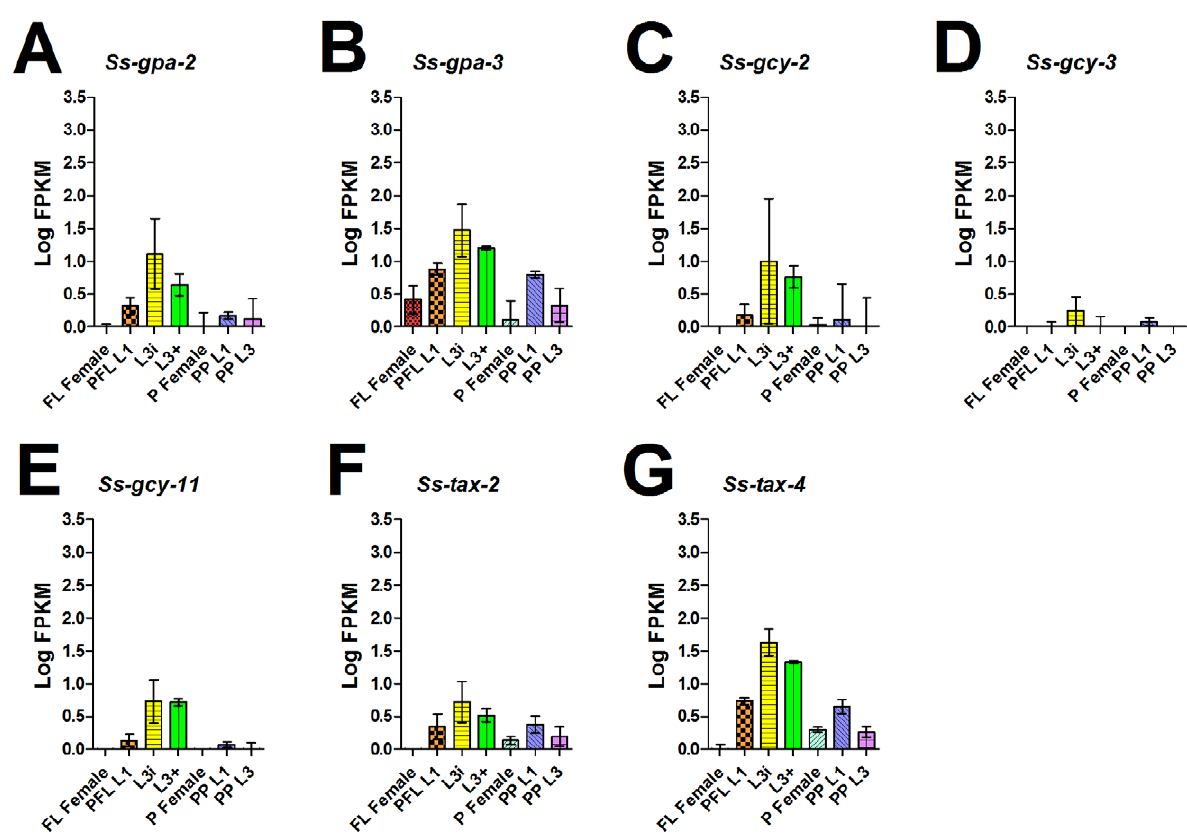
Figure 4. S.stercoralis cGMP signaling pathway homologs are coordinately up-regulated in L3i. Transcript abundances were determined for the coding region of: (A) Ss-gpa-2 and (B) Ss-gpa-3 , the genes encoding homologs of the G-protein a subunits Ce -GPA-2 and Ce -GPA-3, respectively; (C) Ss-gcy-2 , (D) Ss-gcy-3 , and (E) S s-gcy-11 , genes which all encode guanylyl cyclase homologs, of which Ss-gcy-11 encodes the S. stercoralis homolog most similar to the guanylyl cyclase Ce -DAF-11; (F) Ss-tax-2 and (G) Ss-tax-4 , genes encoding homologs of the cyclic nucleotide- gated ion channels Ce -TAX-2 and Ce -TAX-4, respectively. Transcript abundances were quantified in seven developmental stages: free-living females (FL Female), post-free-living first-stage larvae (PFL L1), infectious third-stage larvae (L3i), in vivo activated third-stage larvae (L3 + ), parasitic females (P Female), post-parasitic first-stage larvae (PP L1), and post-parasitic third-stage larvae (PP L3). Transcript abundances were calculated as fragments per kilobase of coding exon per million mapped reads (FPKM) and log transformed. Error bars represent 95% confidence intervals. The y-axes were scaled from 0 to 3.5 to aid comparison between genes.